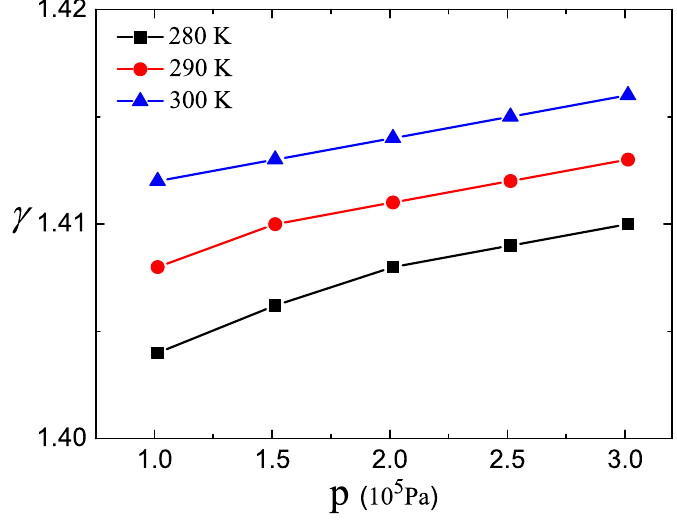
Figure 2. Heat capacity ratio versus the pressure for the different